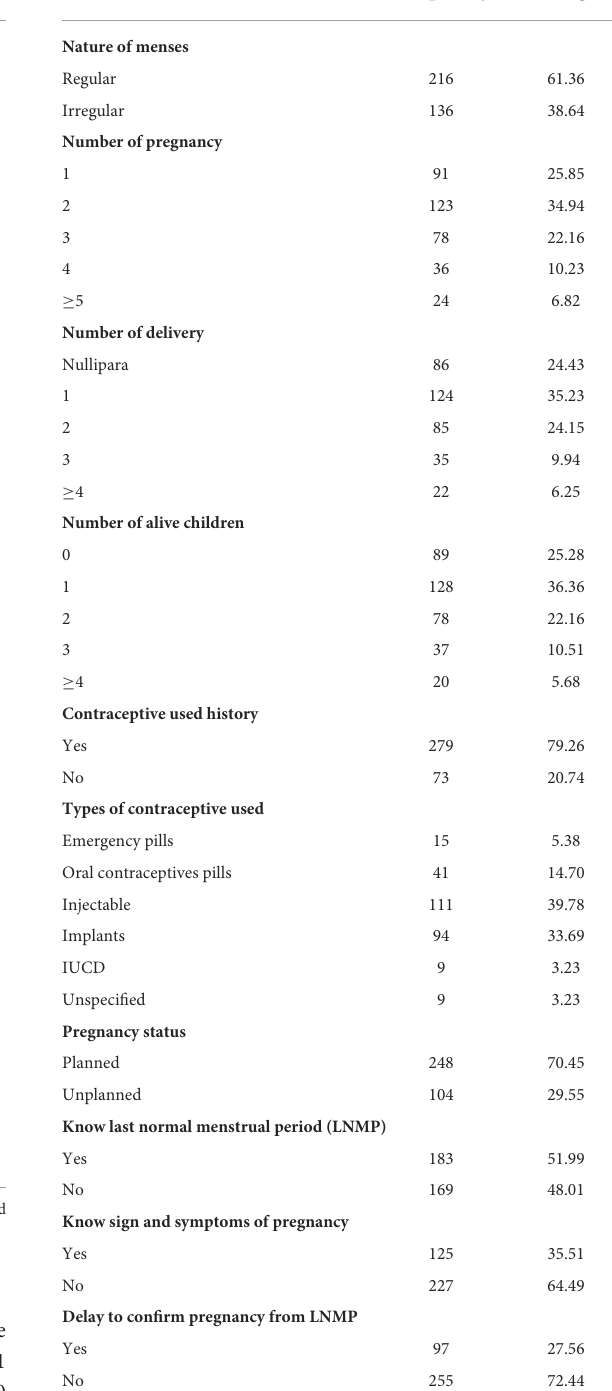
TABLE 1 Socio-demographic and economic characteristics of women who received abortion care services in public hospitals of Arba Minch and Wolayita Sodo town, southern Ethiopia, 2021.